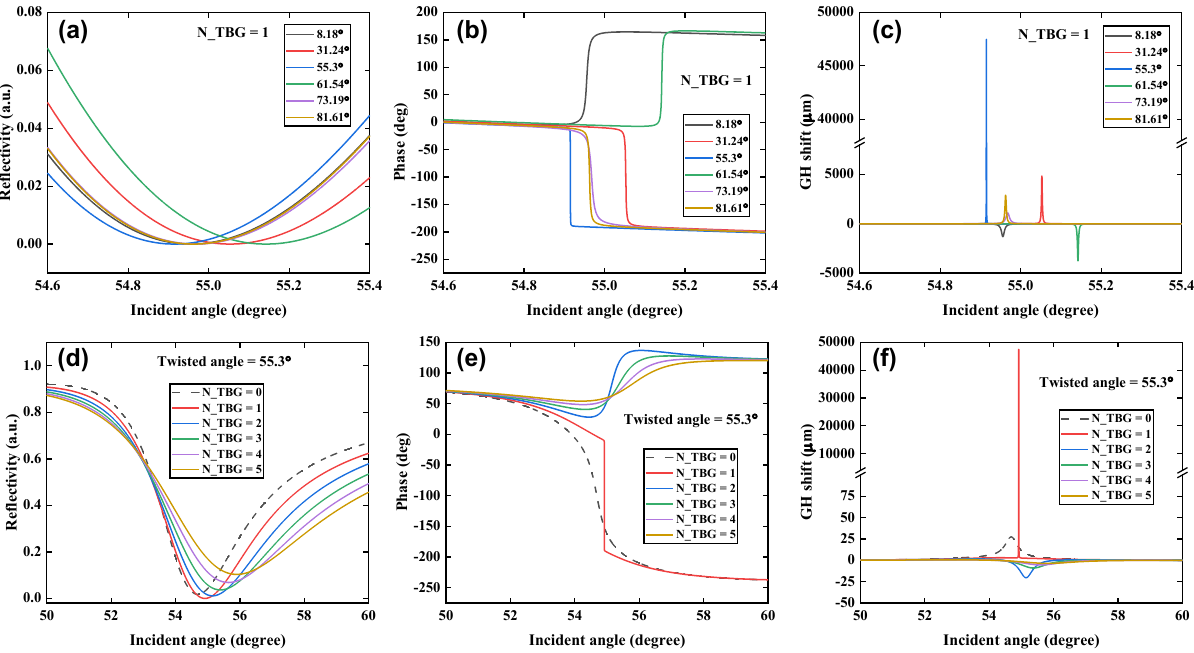
Figure 3: Variation in minimum reflectivity (a), phase (b) and GH shift (c) via varying the twisted angle of 1-TBG system (8.18 ◦ , 31.24 ◦ , 55.3 ◦ , 61.54 ◦ , 73.19 ◦ , and 81.61 ◦ ). Noting that, the number of TBG system is fixed at 1. The thickness of Au film is 44 nm, and the excitation wavelength is 632.8 nm. Variation of minimum reflectivity (d), phase (e) and GH shift (f) by varying the number of TBG system (0–5). Noting that, the twisted angle of TBG is fixed at 55.3 ◦ . The thickness of Au film is 44 nm, and the excitation wavelength is 632.8 nm. N_TBG stands for the number of TBG layer. The running buffers were HEPES, and PBS solutions.